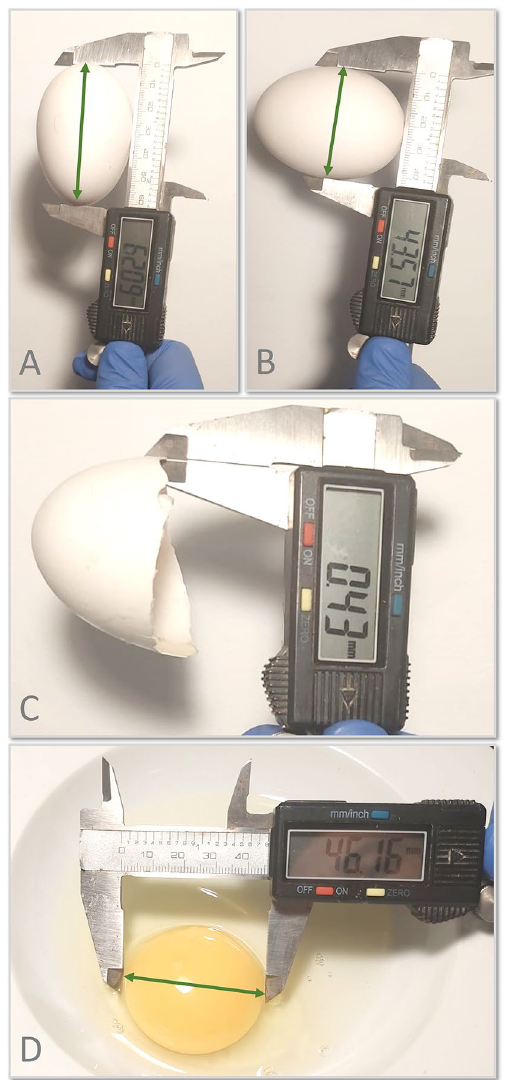
Figure 6. Scheme of the external and internal egg quality data collection procedure. ( A ) Major diameter; ( B ) Minor diameter; ( C ) Eggshell thickness; ( D ) Yolk